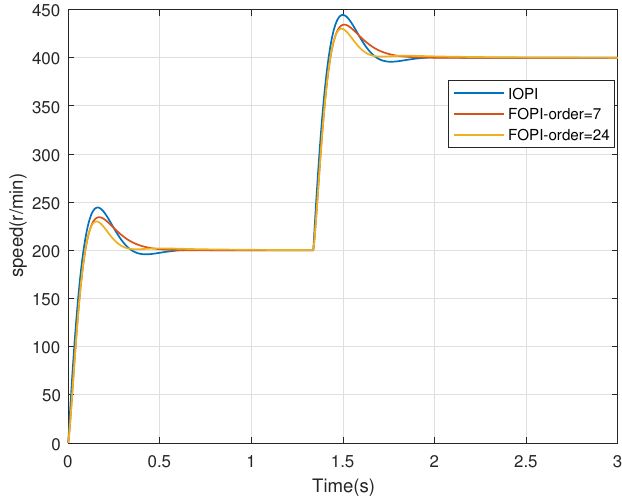
Figure 16. Speed variations response.